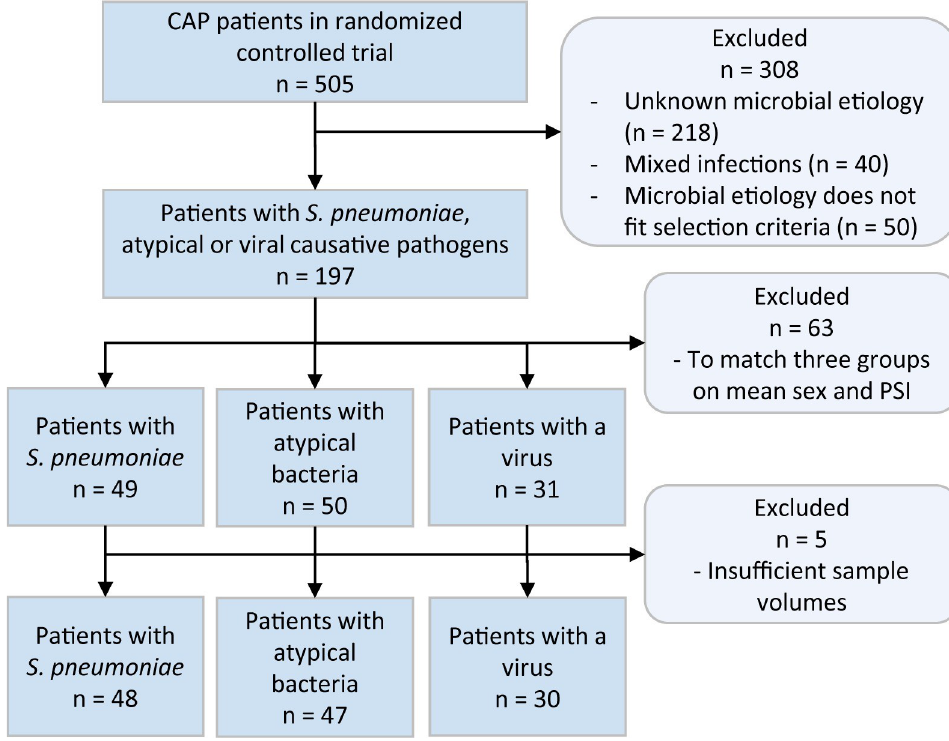
Fig 1. Flow chart of the formation of the three studied patient